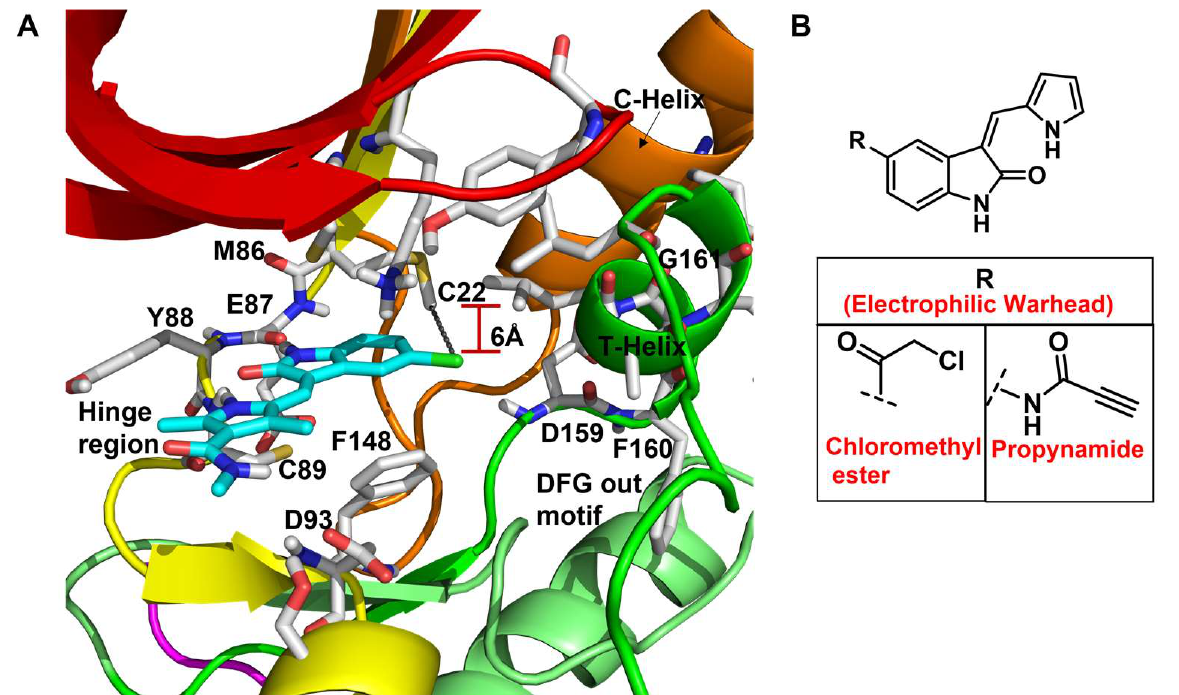
Figure 10. ( A ) The crystal structure of SU11652 bound Nek2 (PDB code 2JAV) revealed a distance of ~6 Å between Cys22 of the protein and the chlorine atom of the ligand, which had been utilized to design and construct new set of irreversible inhibitors. ( B ) Structures of the initial set of developed inhibitors that utilize electrophilic warheads for inactivating the protein.